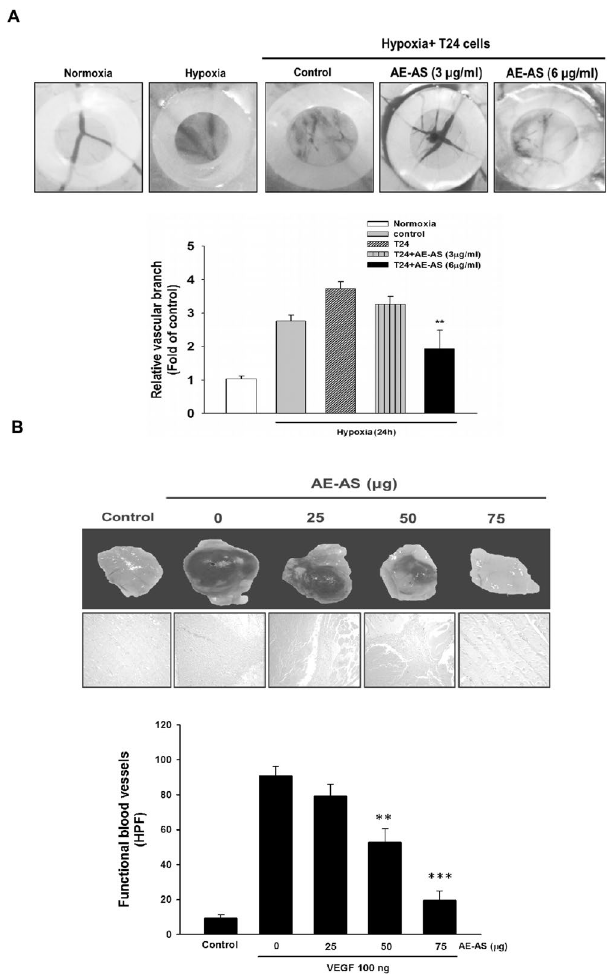
Figure 5. AE-AS inhibited the angiogenesis in CAM and Matrigel plugs. The vessel angiogenesis in CAM was determined and photographed, and the vascular branch was quantified by an angiogenesis-measuring software ( A ). Data was expressed as mean ± SEM (n = 5). ** P < 0.01 versus hypoxia + T24-treated alone group. The functional vasculature formation induced by VEGF (100 ng) in Matrigel plugs was photographed and stained with H&E (200 × ). The infiltrating microvessels with intact RBC were quantified by manual counting using high power fields (200 × ) ** P < 0.01, *** P < 0.001 versus VEGF-treated alone